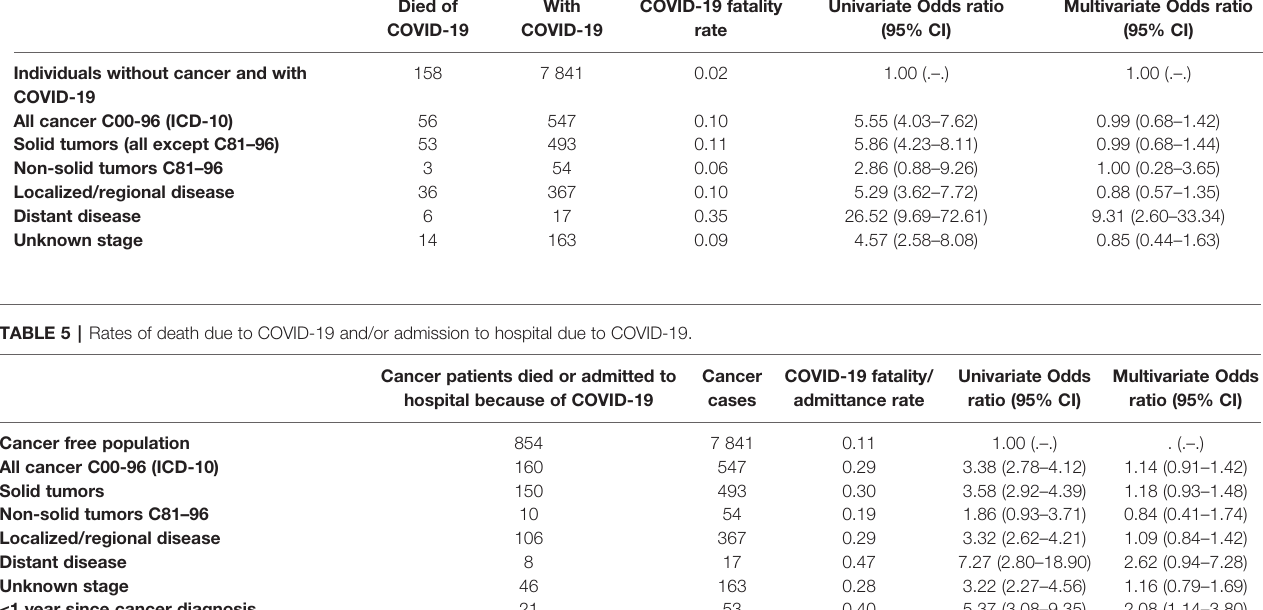
TABLE 4 | Fatality rates and odds ratios of death due to COVID-19 among cancer patients compared to the rate of death due to COVID-19 among the population without cancer.